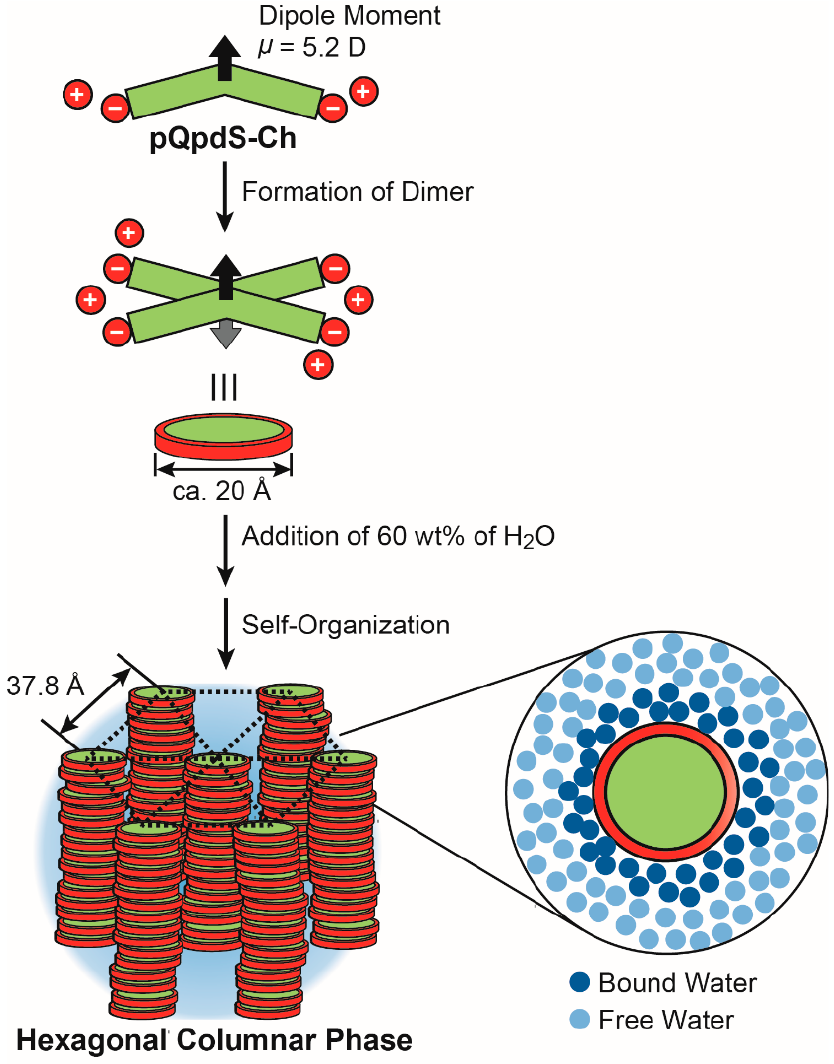
Figure 8. A schematic image of the molecular assembled structure of the pQpdS-Ch /H 2 O (X = 60) mixture in the Col h phase.